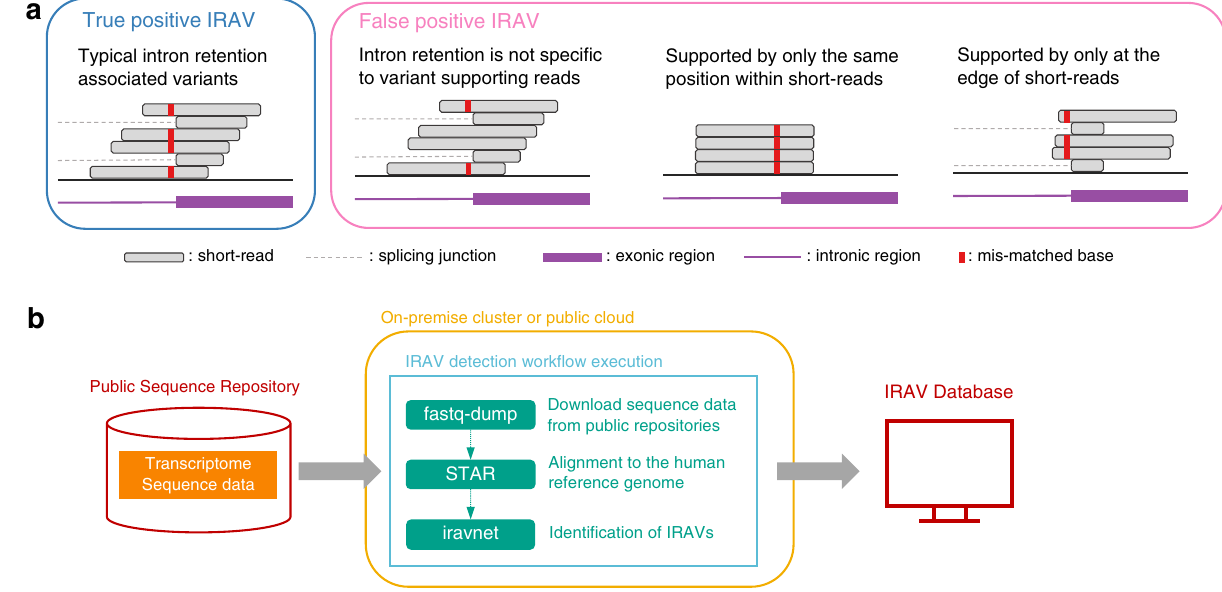
Fig. 1 | Schematics of identi fi cation intron retention associated variants. a Examples of transcriptome sequencing alignment around variant causing intron retention, as well as common patterns of false positives. b Overview of the pro- posed framework for detecting intron retention associated variants from